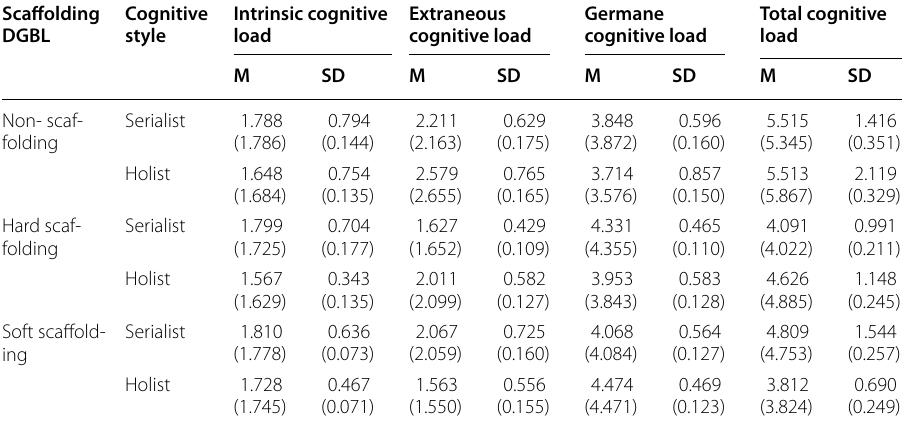
Data in the parentheses was adjusted mean and adjusted standard